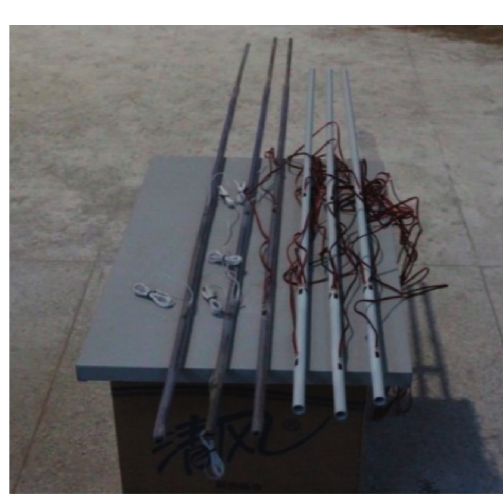
Figure 4: Strain gauge distribution within the surface well. Table 2: Strain gauge